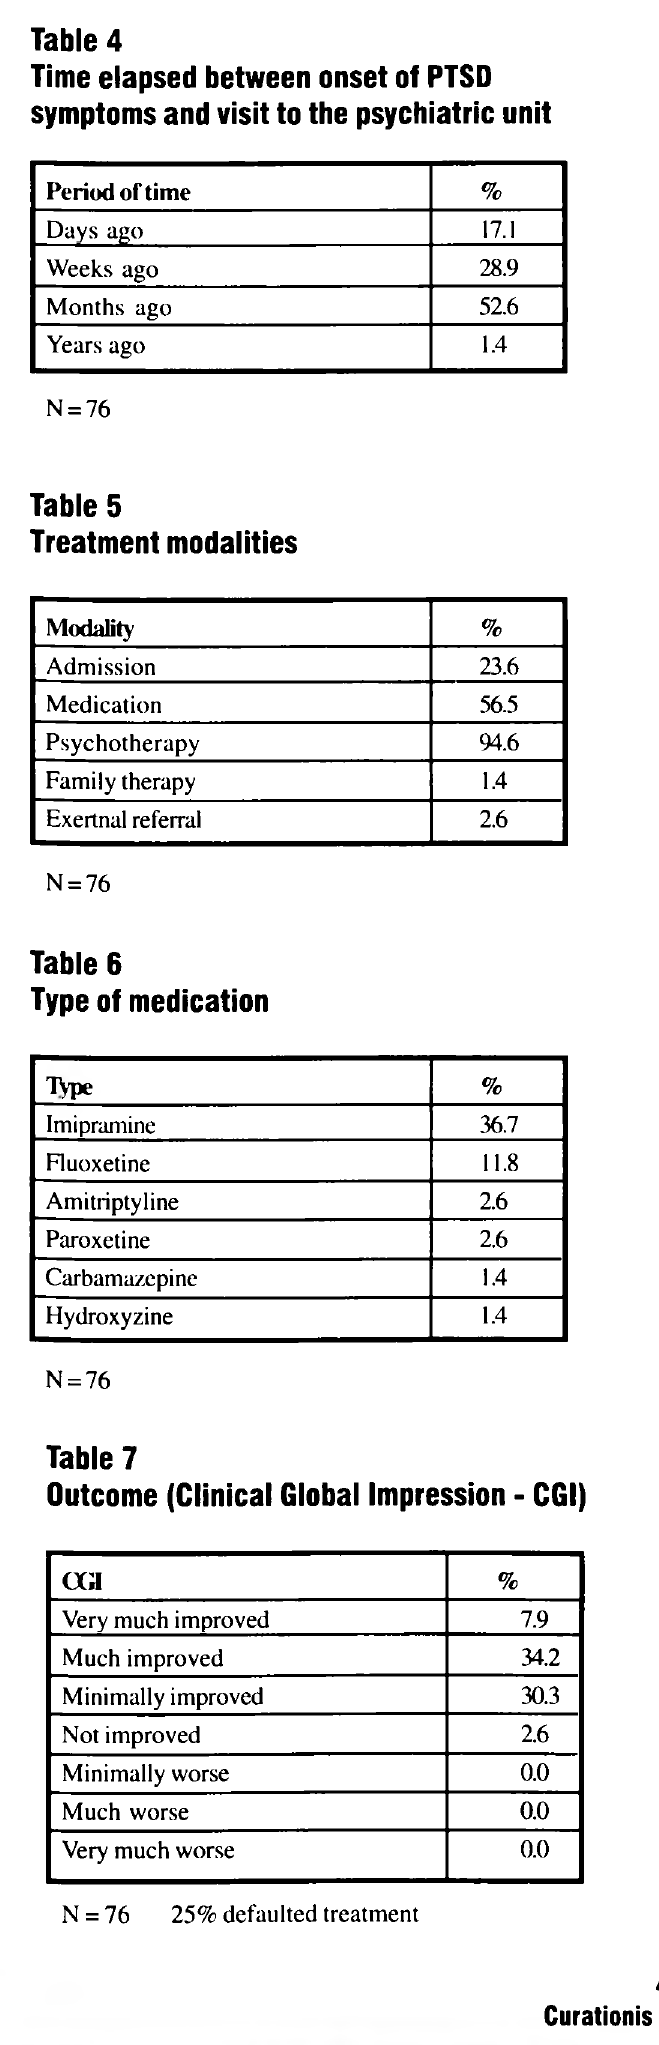
Outcome (Clinical Global Impression -